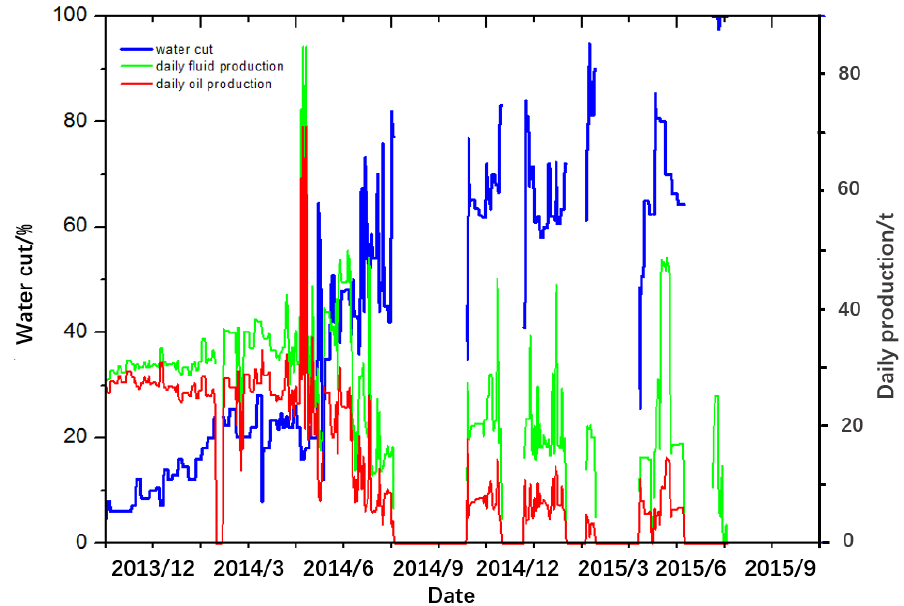
Figure 12. Data of crude oil and liquids production over time in HX well before treatment.